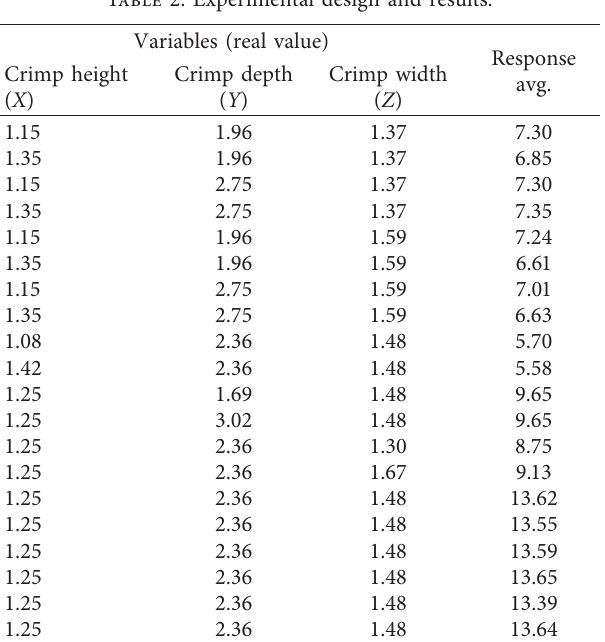
Table 2: Experimental design and